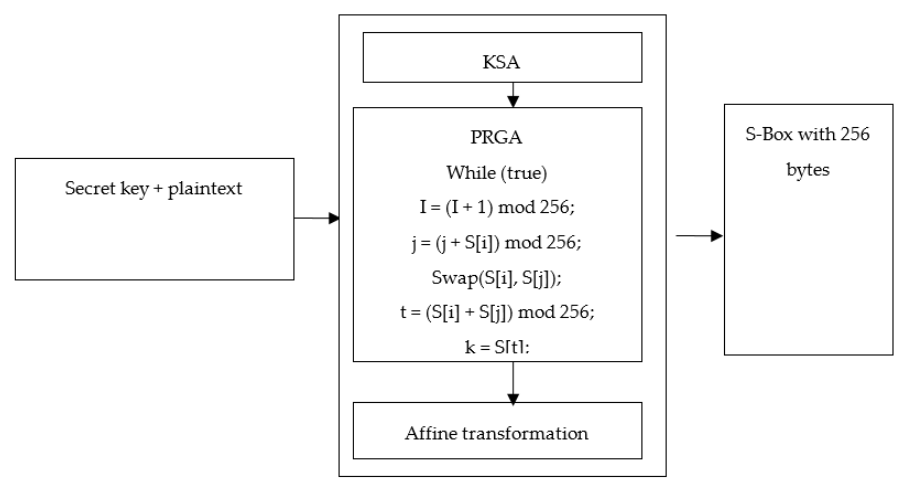
Figure 3. Block diagram of the key and plaintext dependent S-Box with RC4 algorithm.